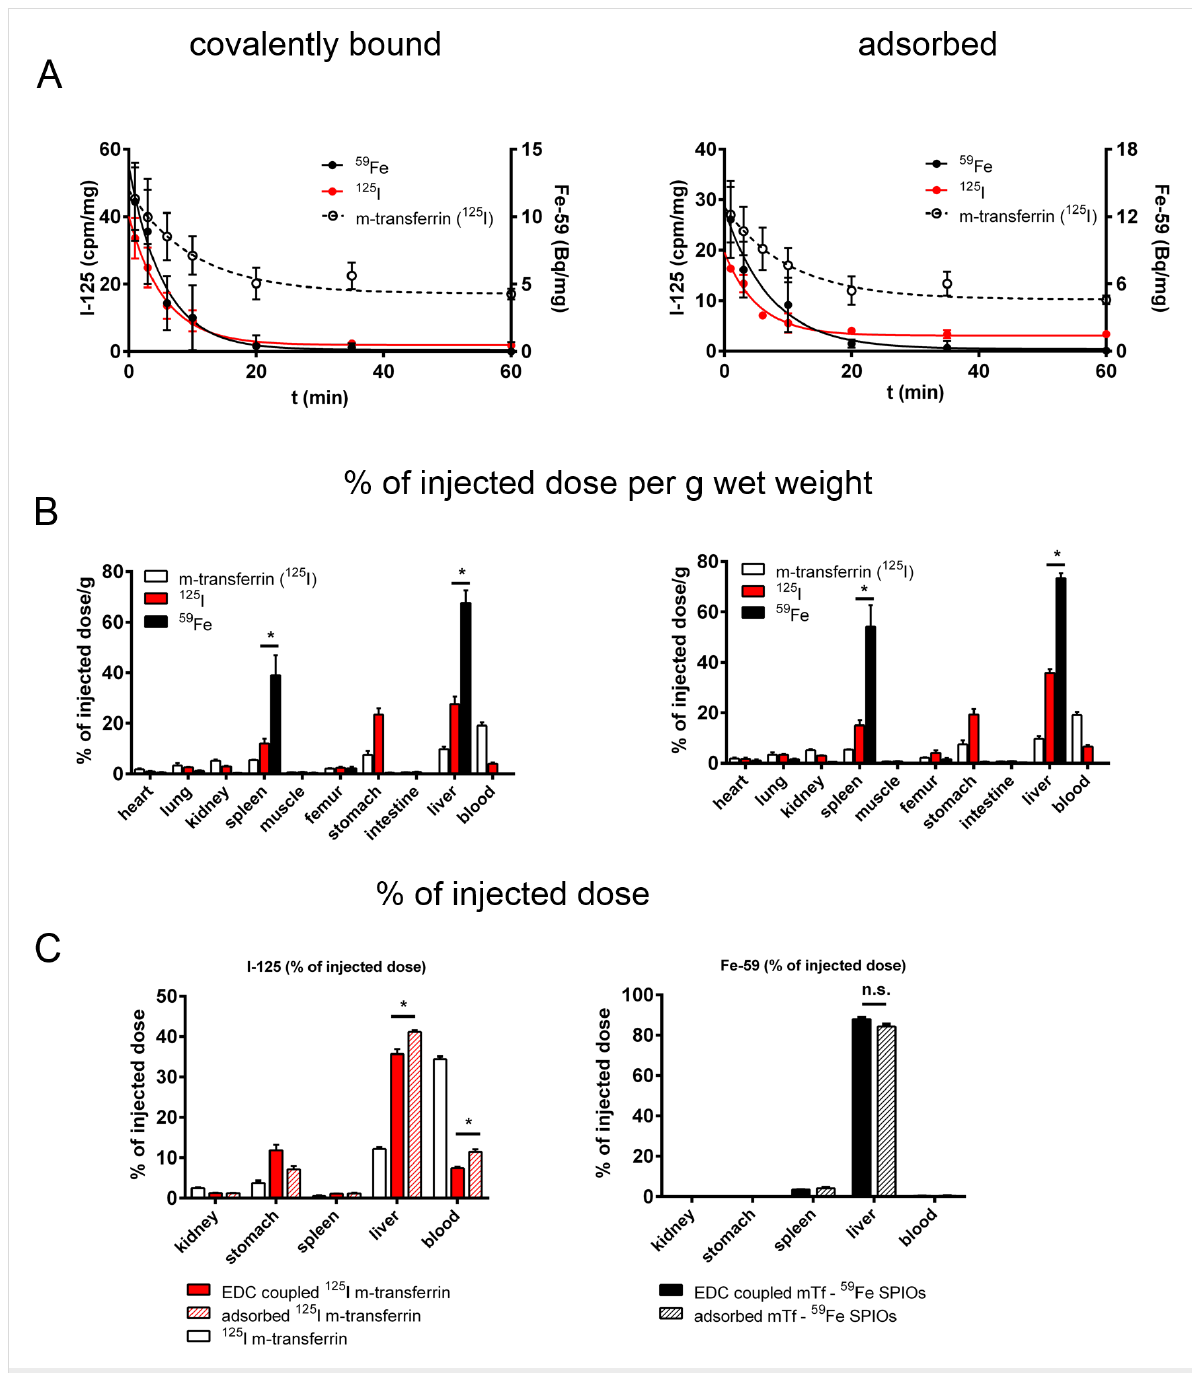
Figure 6: Fate of a preformed transferrin corona in vivo. A, activity of 59 Fe and 125 I (1–120 min) in blood; B and C, activity of 59 Fe and 125 I in organs 120 min after i.v. injection of 59 Fe-SPIOs with a preformed protein corona of adsorbed (A,B right side) or covalently bound (A,B, left side) 125 I-mouse-